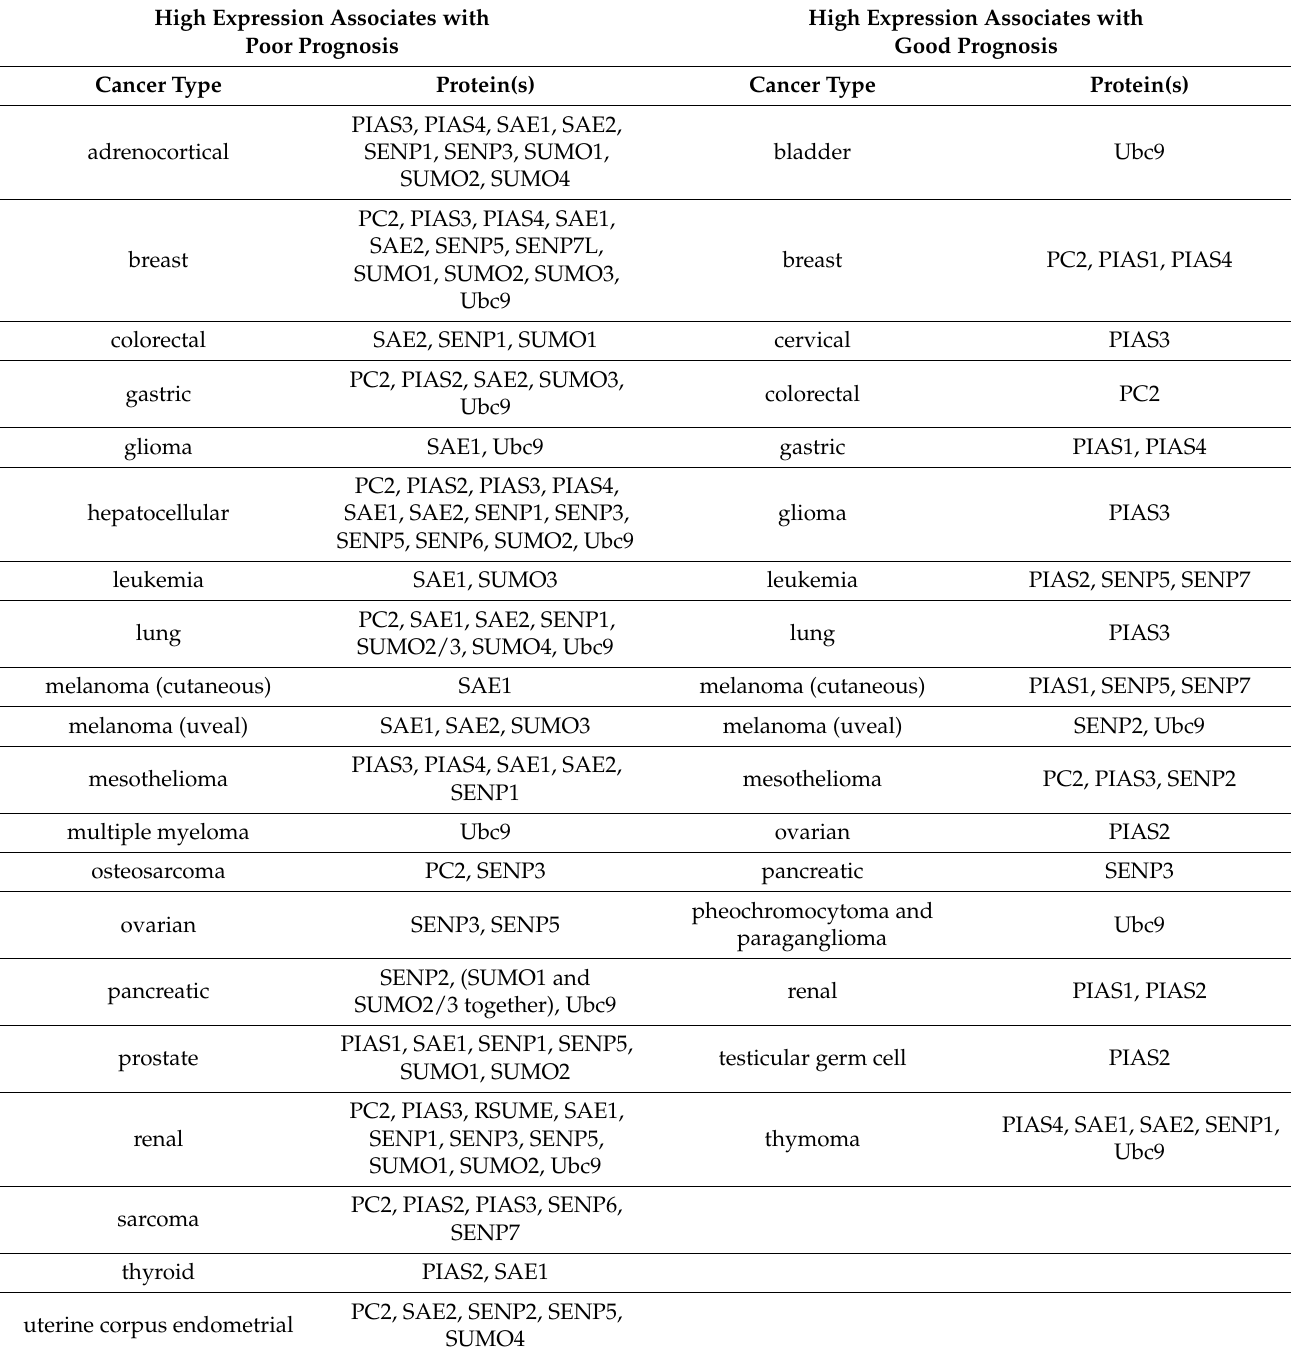
Table 1. Prognostic value of SUMO pathway components. More comprehensive list of studies with prognostic and expression data and all references are in Supplementary Table